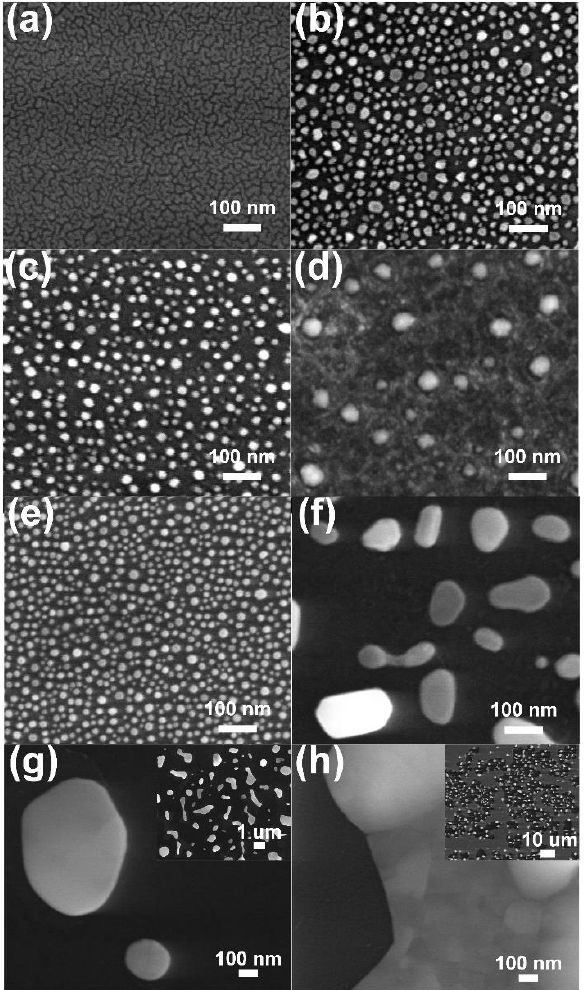
Figure 2. SEM images of gold masks with different annealing temperatures and thicknesses: ( a ) initial as-deposited gold film with a thickness of about 3 nm; ( b – d ) sample with gold film shown in ( a ) after sequentially annealing at 600, 800, and 1100 °C for 5 min; ( e , f ) samples with initial gold film thicknesses of 3, 10, 20, and 40 nm after sequentially annealing at 800 °C for 5 min. Insets show ( g , h ) at low magnification, respectively.